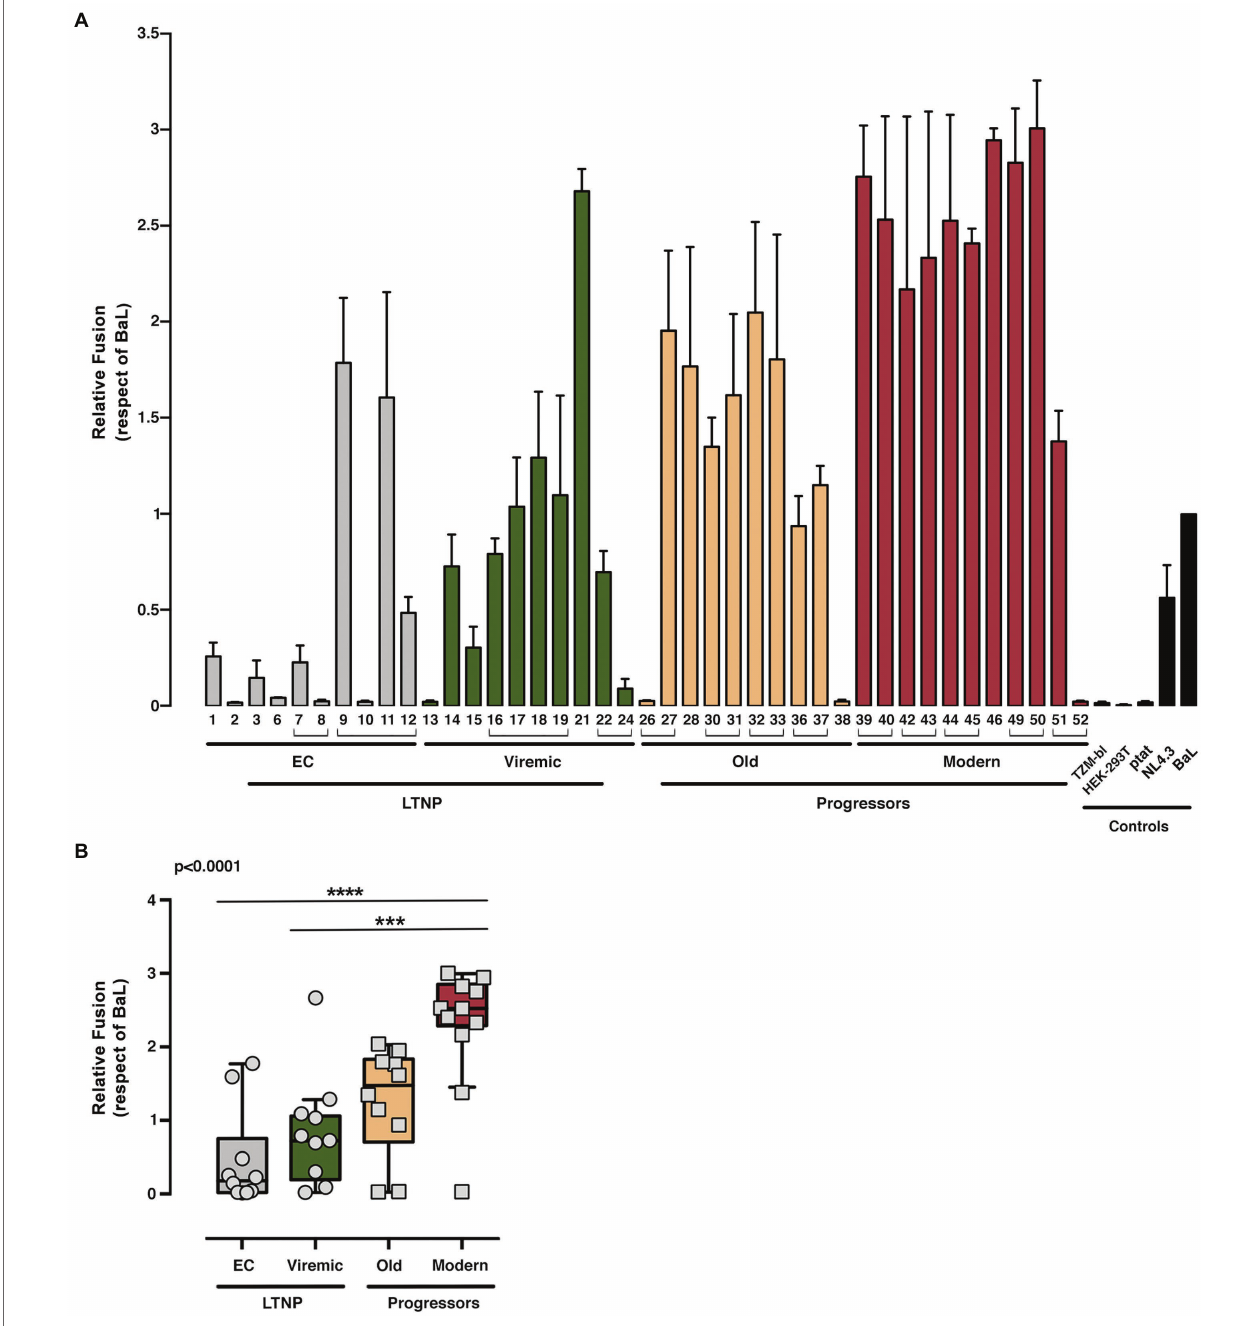
FIGURE 4 | Analysis of membranes fusion-phenotypic features of HIV-1 Envs isolated from LTNP-EC, viremic LTNP, and P individuals. Analysis of the ability to induce cell-to-cell fusion of HIV-1 Env proteins obtained from LTNP-EC ( gray bars ), vLTNP ( green bars ), Old ( orange bars ), and Modern individuals ( red bars ) or reference HIV-1 viral strains (ptat, NL4.3, and BaL, black bars ). (A) Env fusogenic activity for each patient in each group is shown. Envs isolated from the same patient are associated with brackets. (B) Relative fusion activity of the full Env collection compared to the BaL control established at 100% and grouped in the different groups of patients is shown. Values are mean ± SEM of three independent experiments ( n = 3). Statistical analysis was performed using Kruskal–Wallis, Dunn’s Multiple Comparisons Test; value of p for comparison between all groups is shown, top left . When indicated, comparative p values between groups are *** p <0.001 and **** p